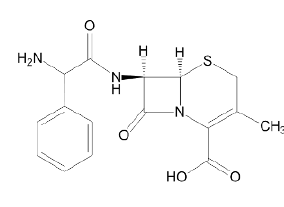
Figure 1. Chemical structure of